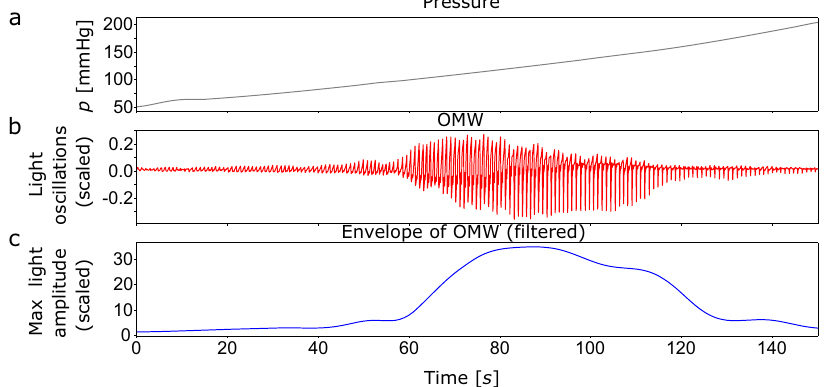
Fig. 10 Detailed example of the oscillometric wave. An example for an oscillometric wave (OMW) is shown from subject 1. a The pressure p c ( t ) is increased approximately linearly. b OMW – in detail v Pulse ( t ) – is recorded. c The resulting OMW envelope derived from the oscillations of v Pulse ( t ).